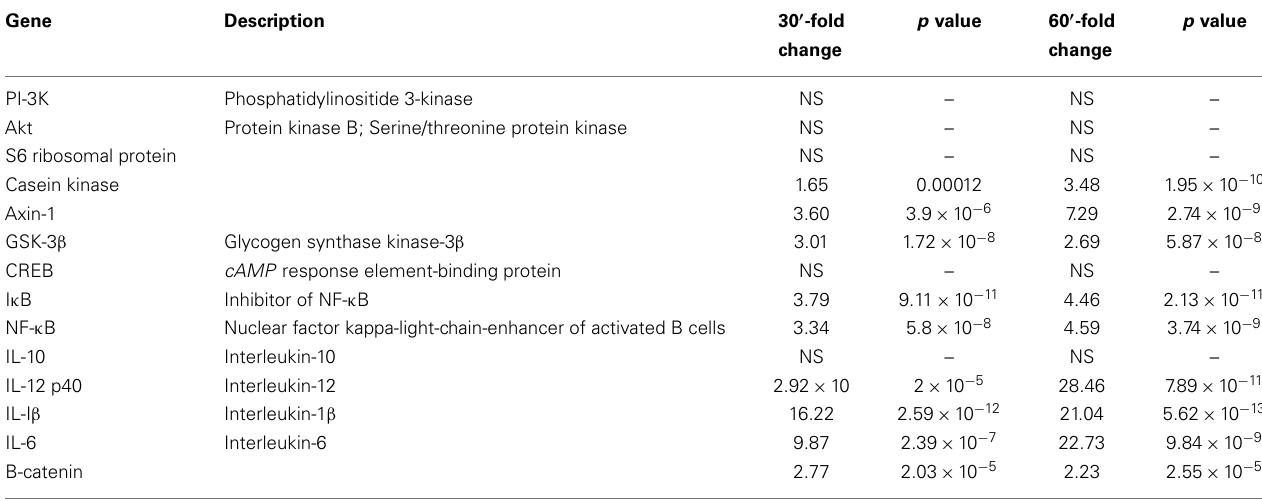
Table 1 | GSK-3 β pathway genes from DNA microarray